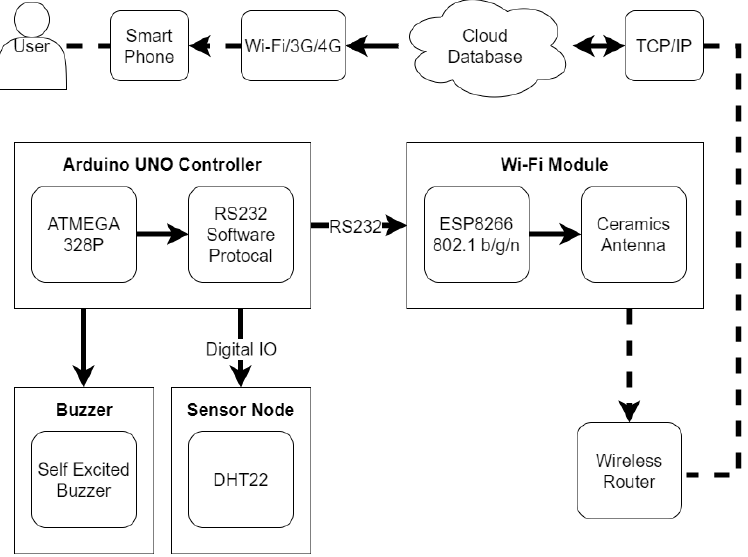
Figure 6. The hardware framework of the sensing node.